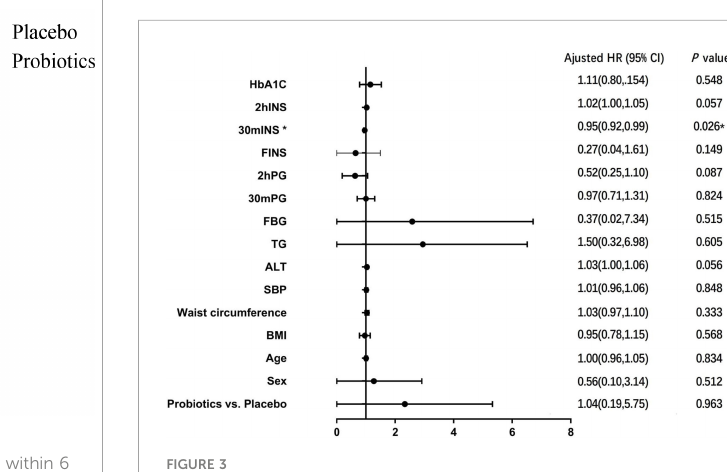
FIGURE 3 COX regression analysis of risk factors for T2DM after 6